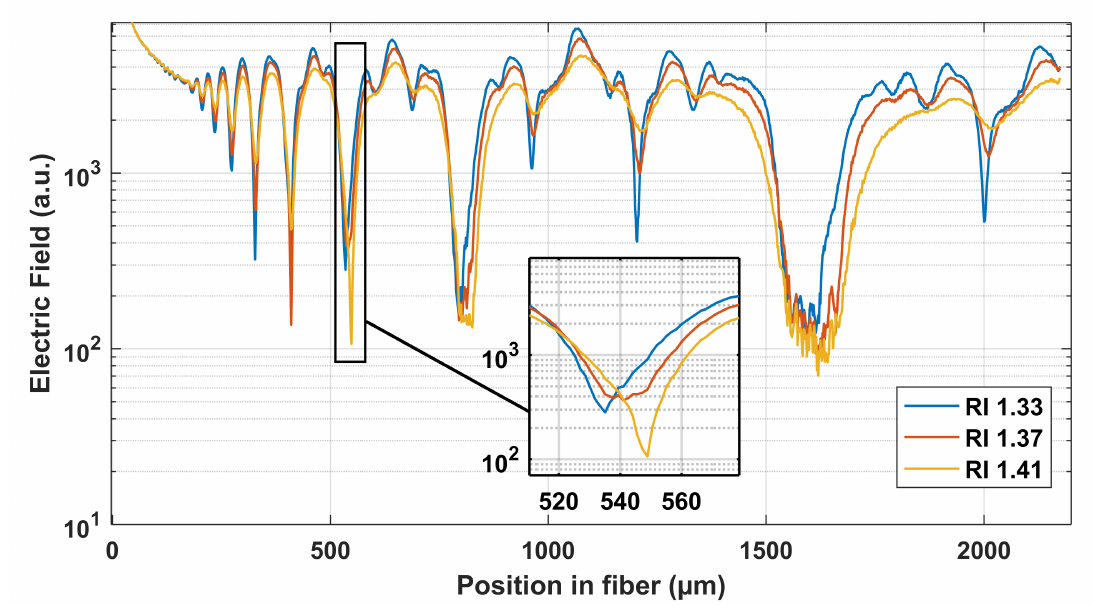
Figure 4. Electric field in the center of fiber, at wavelength 1550 nm and different surrounding refractive indexes, RI 1.33, 1.37 and 1.41. The inset shows an enlargement of the destructive interference around 540 um where a small shift is observed for increasing